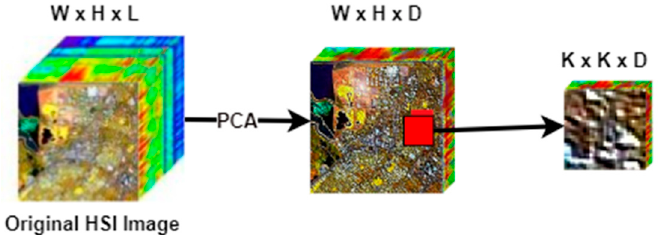
Figure 1. Preprocessing part.